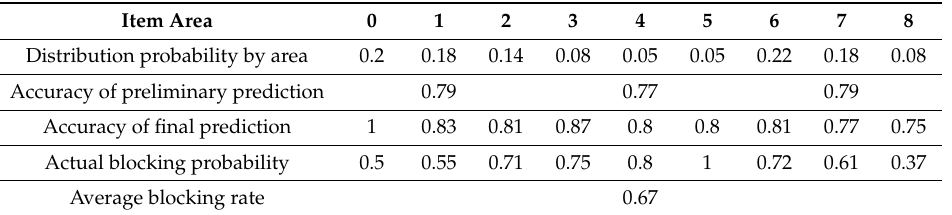
Table 12. One hundred actual game